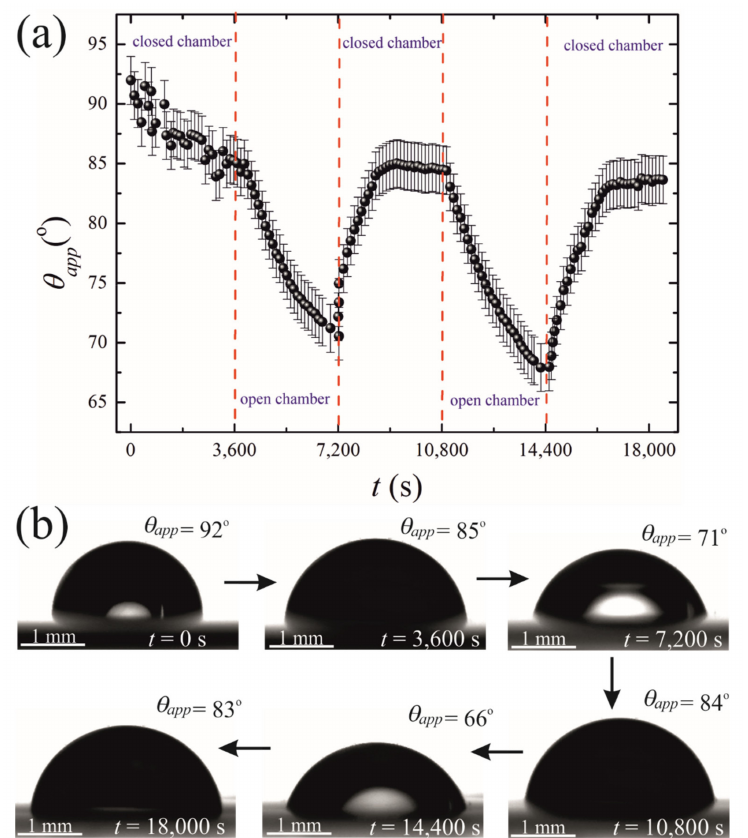
Figure 5. ( a ) Time evolution of the apparent contact angle θ ( t ) is depicted. ( b ) Sequence of images illustrating the side view of the time evolution of the droplet placed on the PDMS membrane is shown.